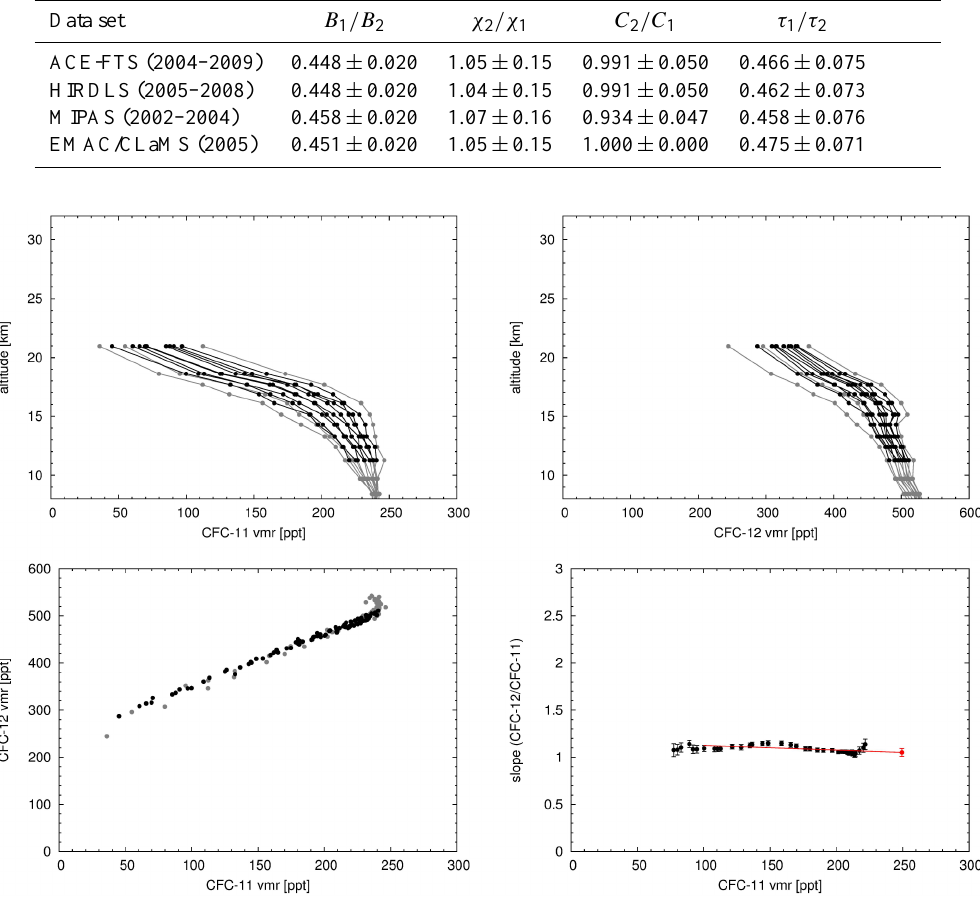
Figure 4. Volume mixing ratio (vmr) profiles of CFC-11 (top, left) and CFC-12 (top, right), tracer–tracer correlations (bottom, left), and tracer–tracer slopes (bottom, right) used to estimate lifetimes from ACE-FTS data. Black color indicates midlatitude data. Grey color indicates data from other latitudes. The red line shows a linear fit used to extrapolate the tracer–tracer slope at the tropopause (red